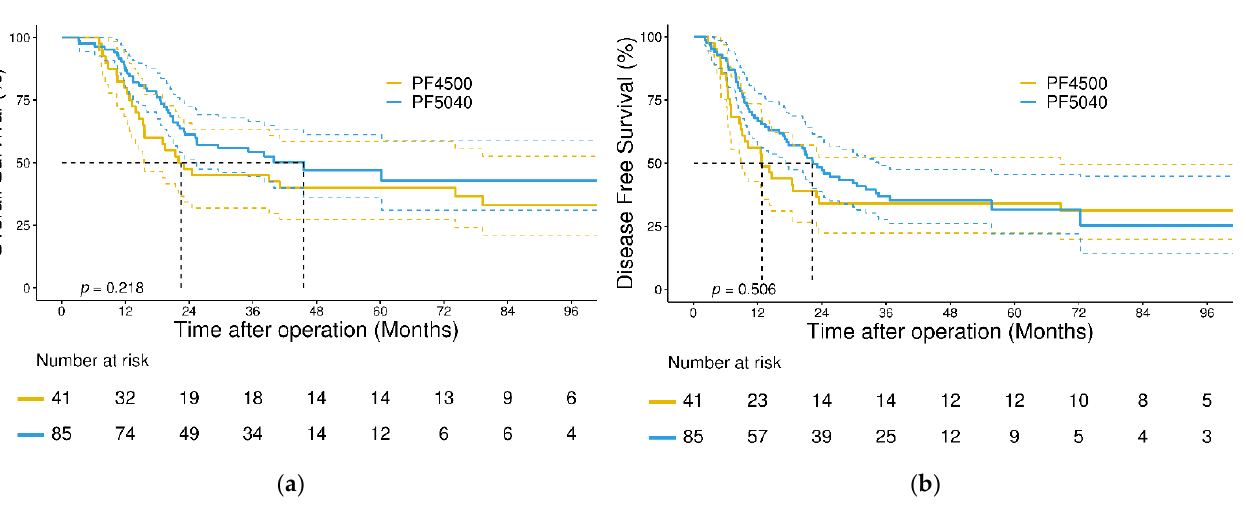
Figure 1. ( a ) Kaplan – Meier analysis of overall survival in the entire cohort, stratified according to regimens; ( b ) Kaplan – Meier analysis of disease-free survival in the entire cohort, stratified according to regimens.